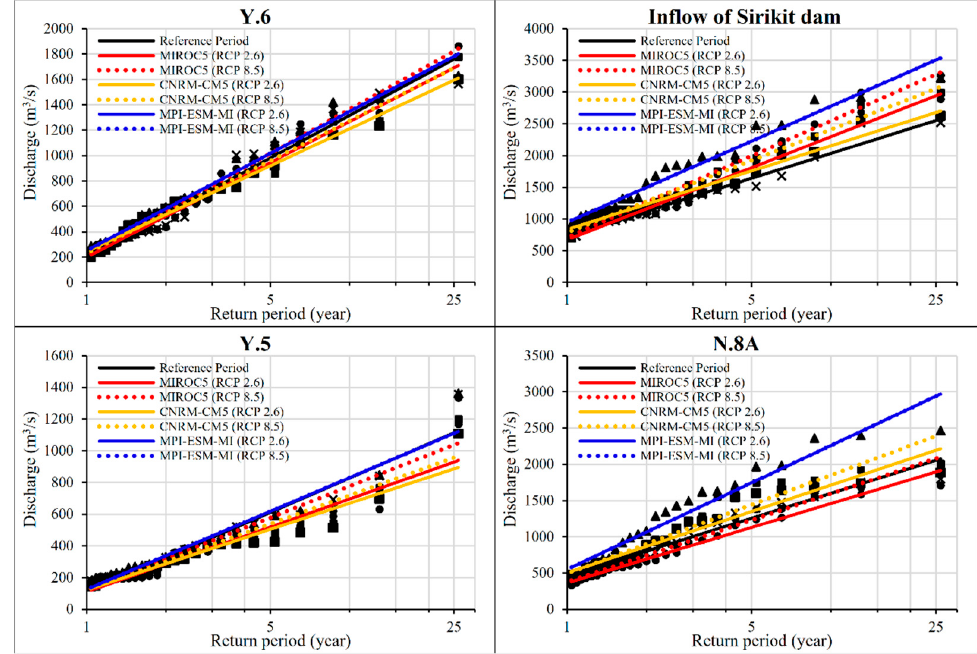
Figure 12. Return period of peak discharge in the near future (2021–2045) under scenarios RCP 2.6 and RCP 8.5 compared with the reference period.